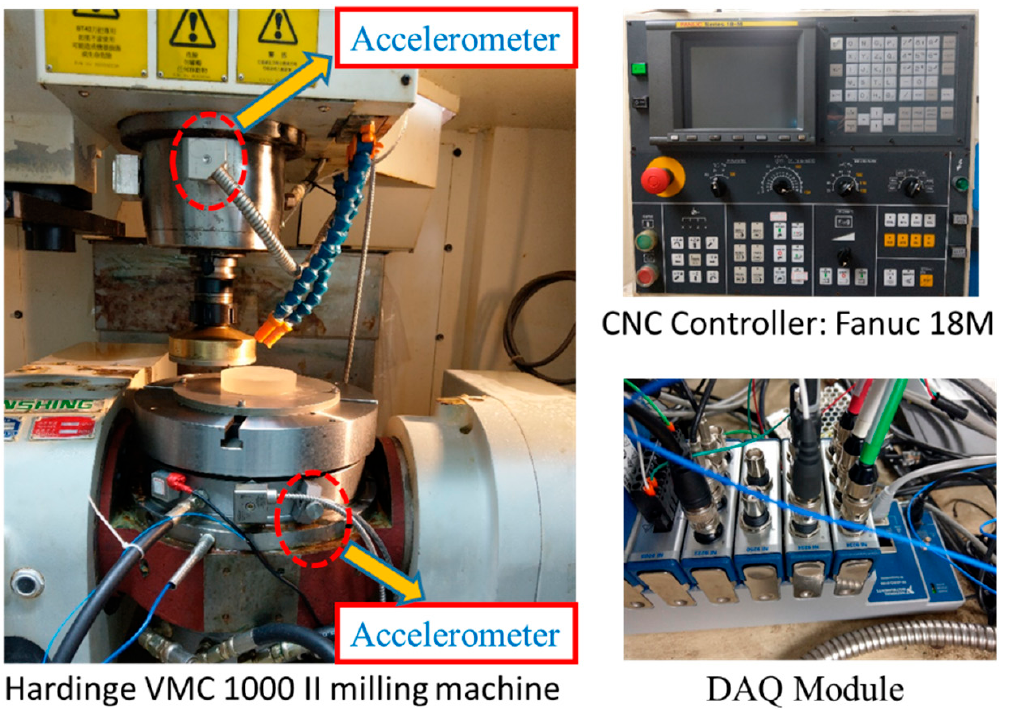
Figure 1. Sensors installed on Hardinge VMC 1000 II milling machine.